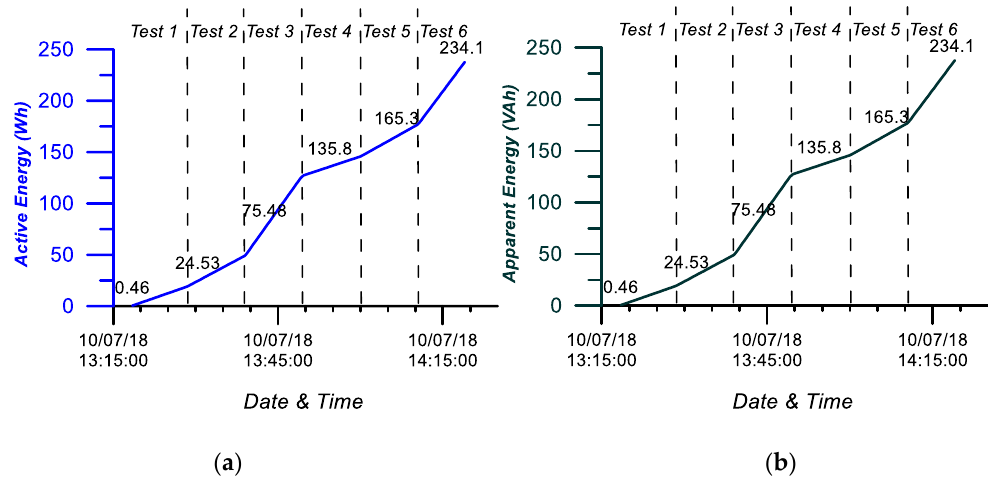
Figure 17. ( a ) Active Energy during the long-term monitoring test. ( b ) Apparent Energy during the long-term monitoring test.